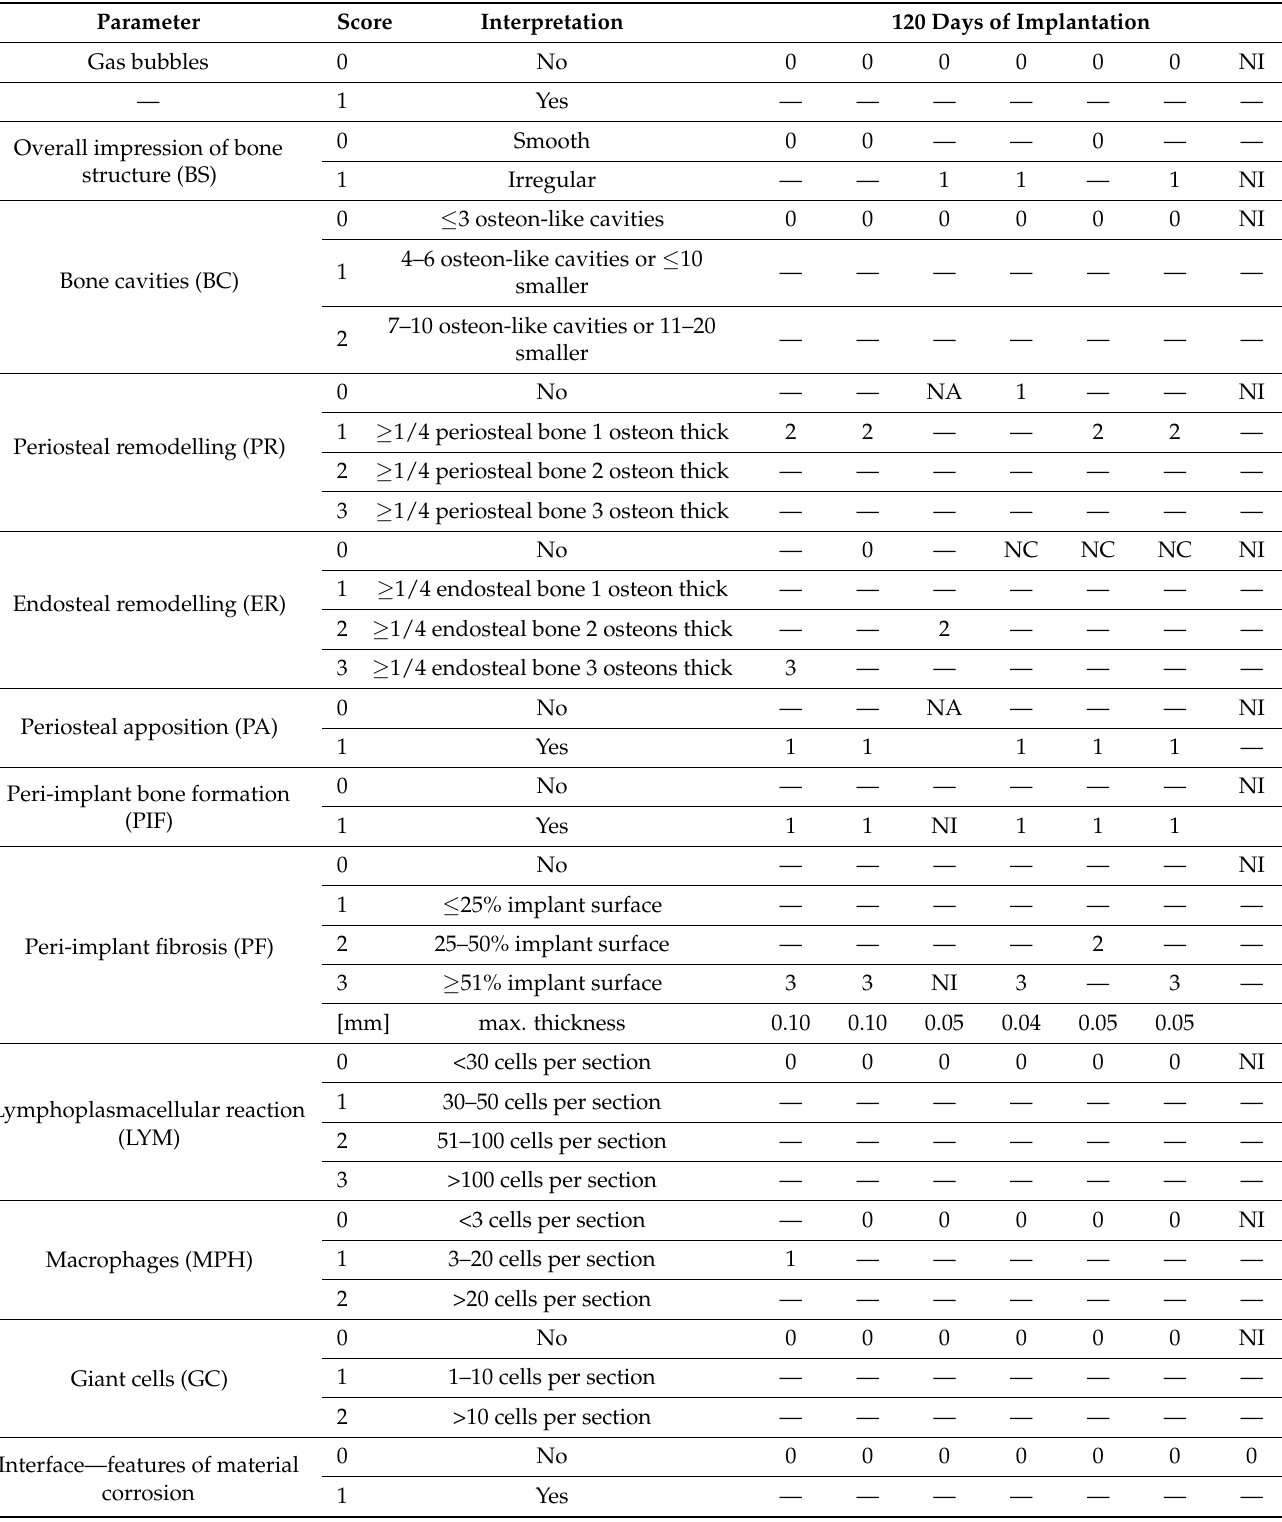
Table 2. Evaluation of the healing process according to parameters on histology of specimens (Reifenrath et al.) [35]. Parameter Score Gas bubbles